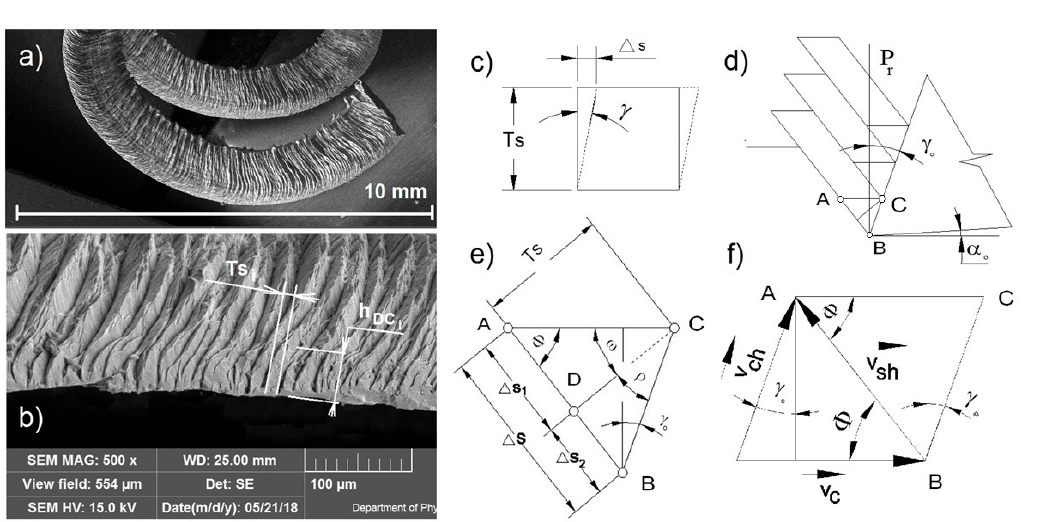
Figure 4. Analysis of the chip formation model when cutting: ( a ) Continuous chip; ( b ) Position of the measured lamella; ( c ) The shear deformation of the lamella; ( d ) Geometry of the cutting tool; ( e ) Model of the shear deformation in the primary zone; ( f ) Speed vector diagram.